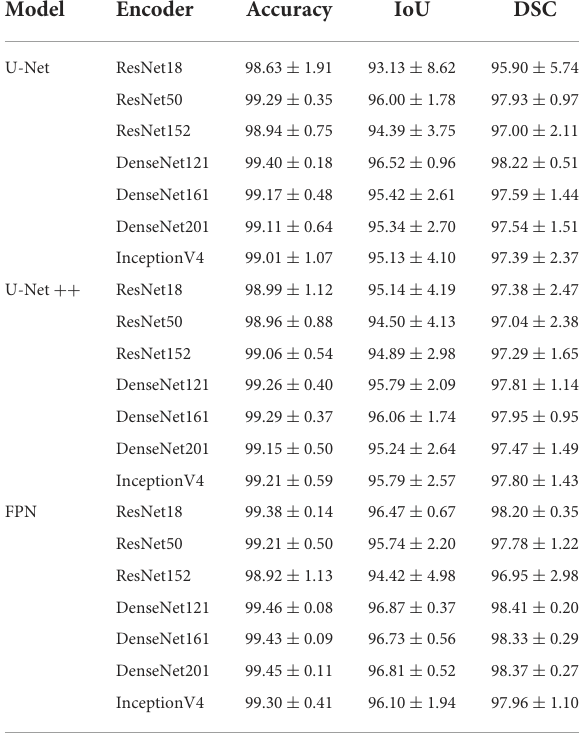
TABLE 1 Performance metrics (%) for penile shaft segmentation, comparing computed over test (unseen) set using three network models and seven encoder